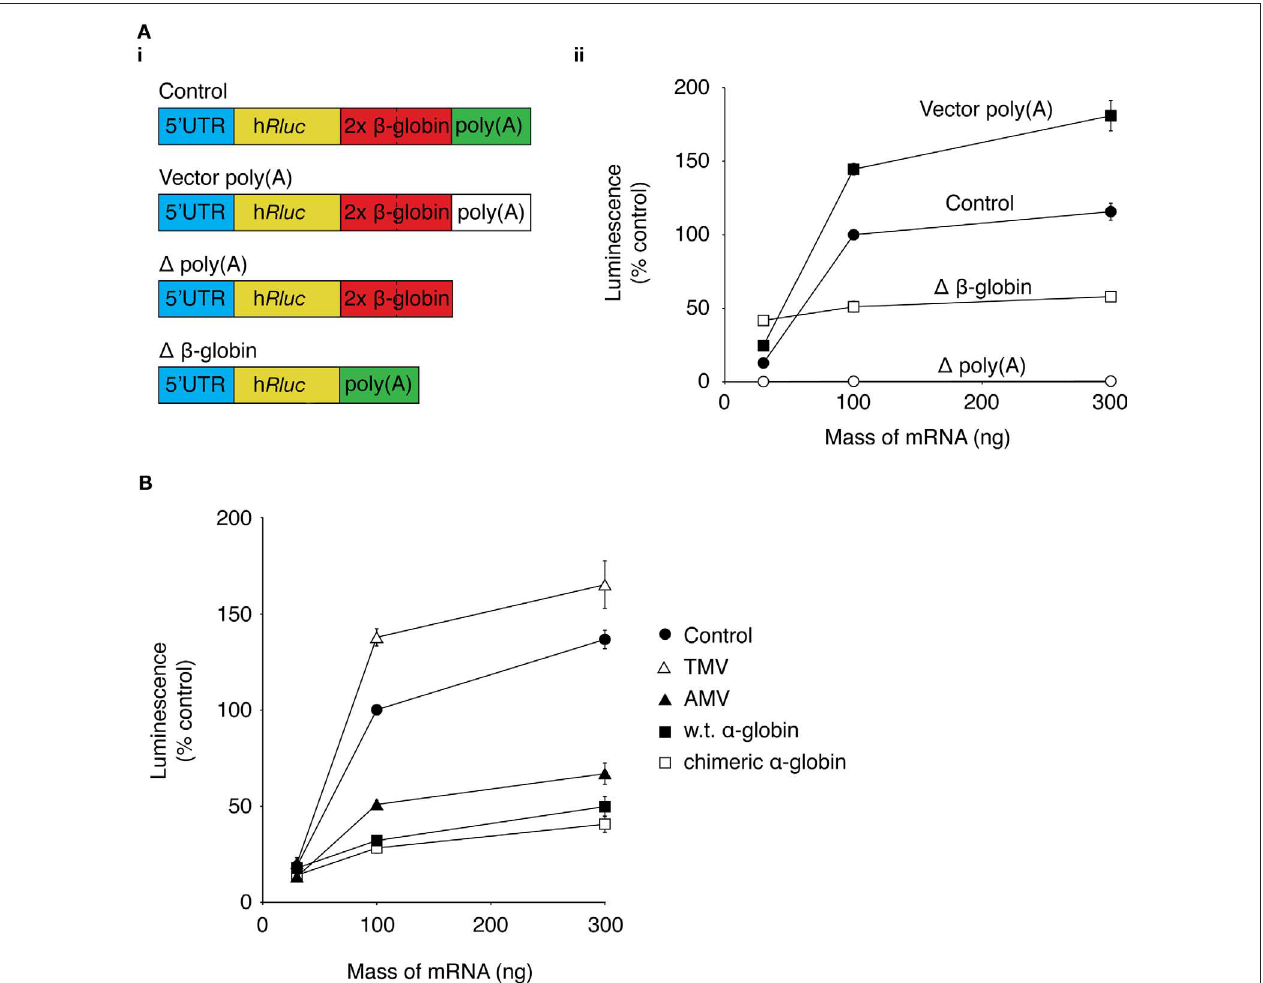
poly ( a ) ; ¡ ). Data were normalized to luciferase activity of neurons transfected with 100 ng of control Rluc mRNA ( n = 3). (B) Graph of luciferase activity of cell lysates from DRG neurons transfected with 30, 100, 300 ng of control Rluc mRNA ( l ) or with the control 5 ′ -UTR replaced with the 5 ′ -UTR from tobacco mosaic virus (TMV; ), alfalfa mosaic virus (AMV; ), rabbit wild type α -globin ( n ), or rabbit chimeric α -globin ( ¨ ). Data were normalized to the luciferase activity of neurons transfected with 100 ng of control Rluc mRNA ( n =